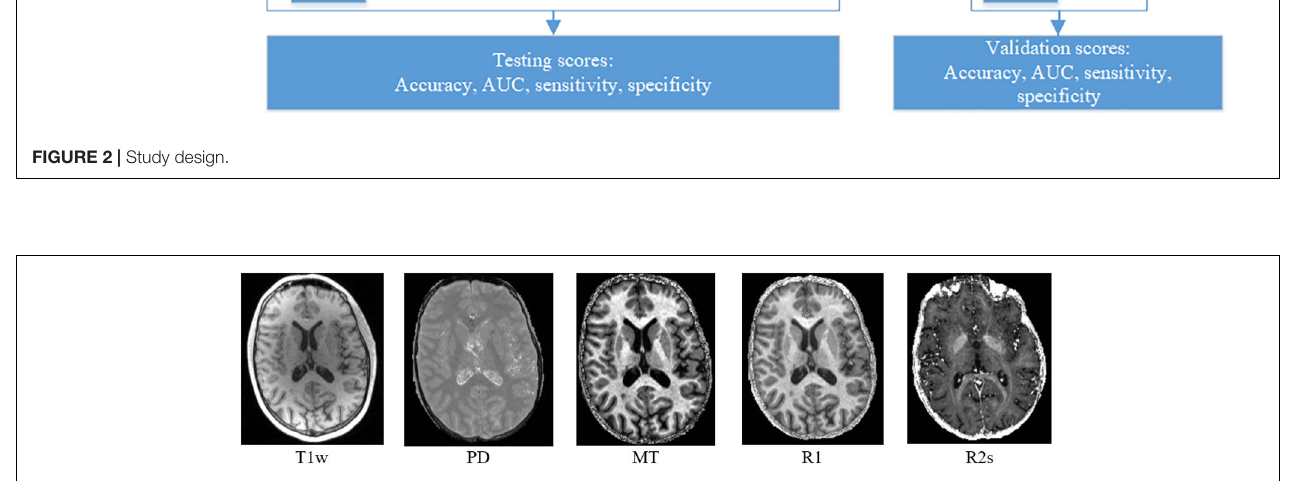
FIGURE 3 | Example of MRI data presented in